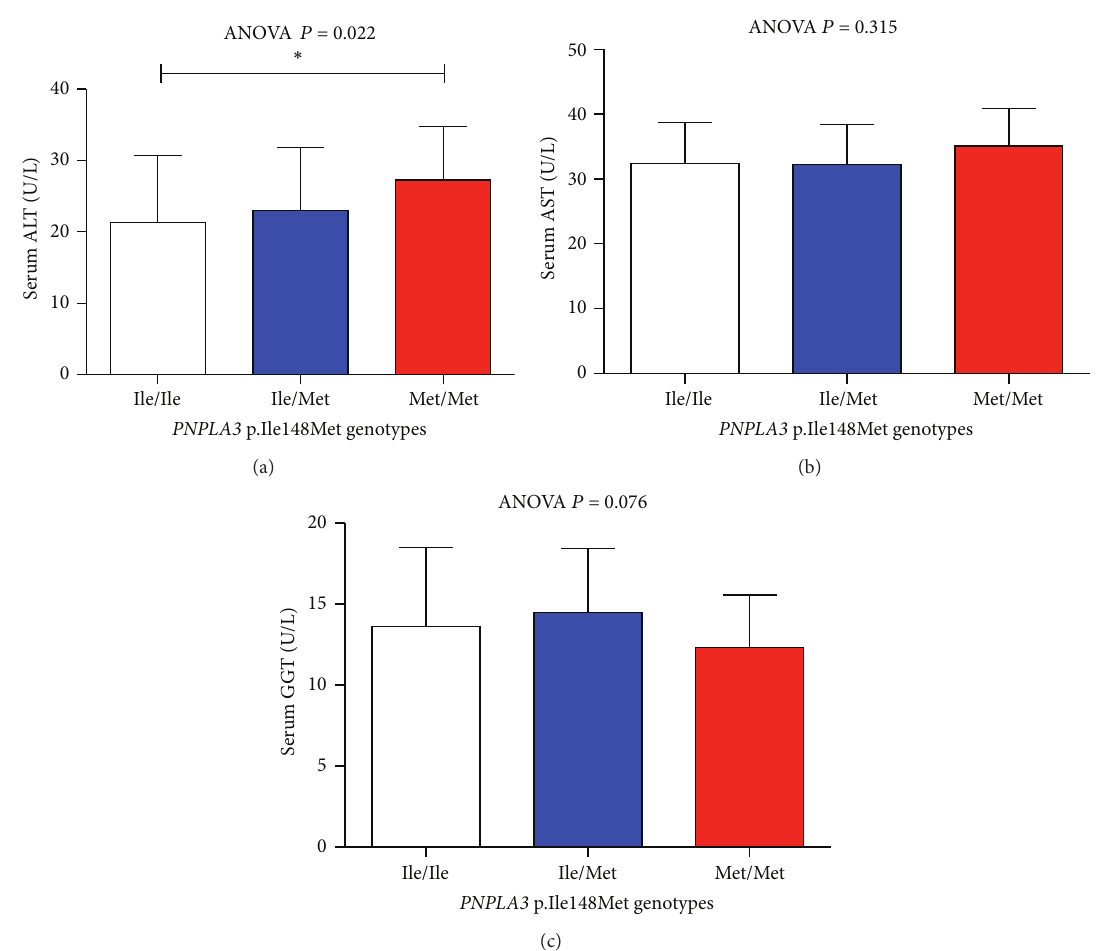
Figure 2: The prosteatotic PNPLA3 variant p.Ile148Met is associated with higher serum ALT activity at young age. Serum ALT activities differ significantly (ANOVA 𝑃 = 0.022 ) between carriers of different PNPLA3 genotypes. Especially children carrying the PNPLA3 p.148Met/Met variant present with significantly ( ∗ 𝑃 = 0.009 ) higher ALT as compared to the carriers of the common variant PNPLA3 p.148Ile/Ile (a). Presence of this variant was not associated with other liver function tests ((b) and